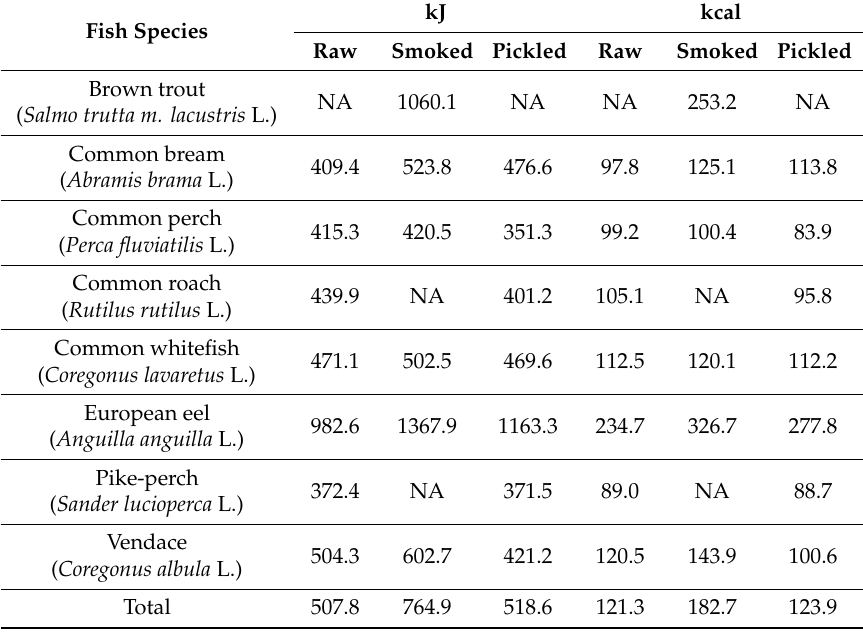
Table 6. Energy value in 100 g of raw, smoked and pickled freshwater fish